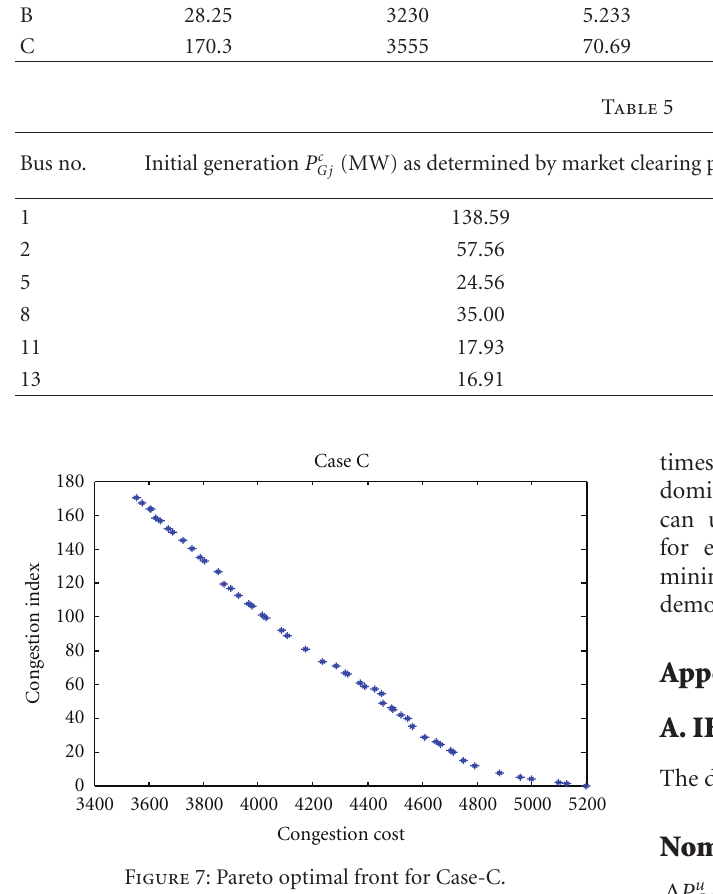
Figure 7: Pareto optimal front for